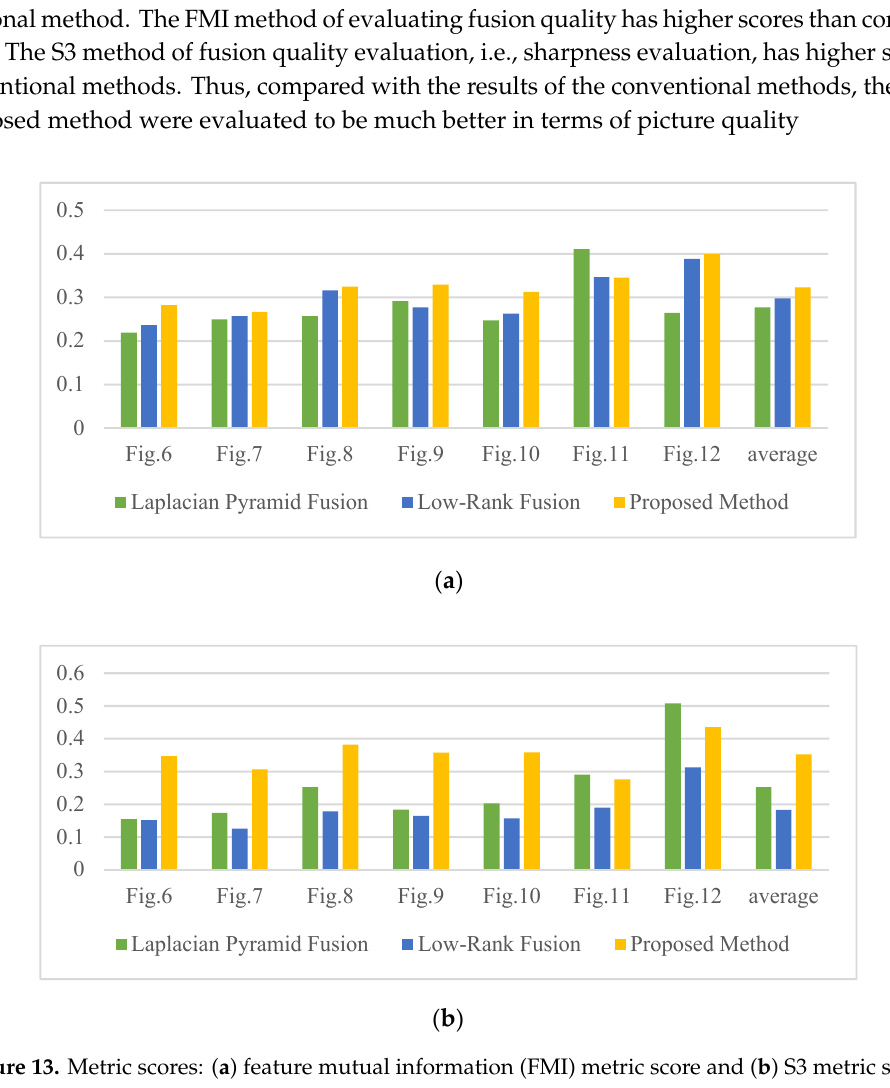
Figure 13. Metric scores: ( a ) feature mutual information (FMI) metric score and ( b ) S3 metric score